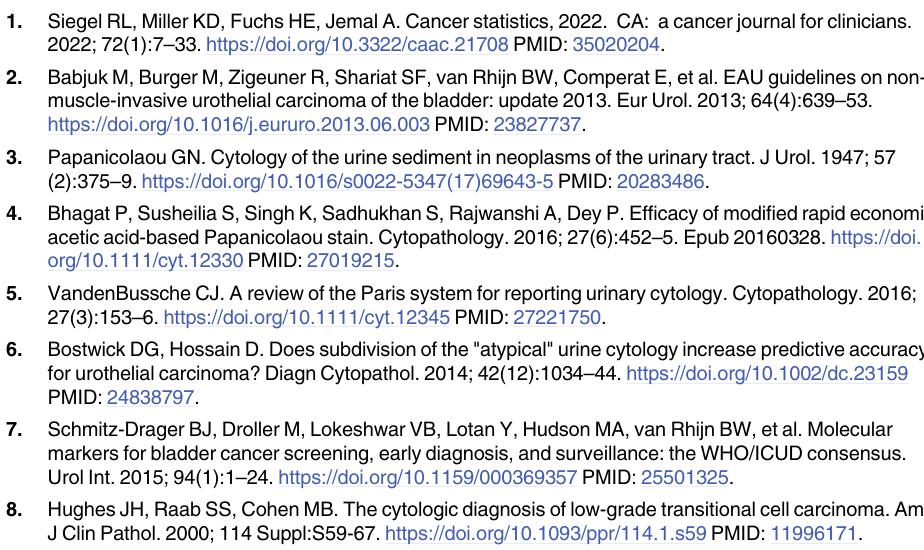
S2 Fig. Effects of CDCP1 knockdown in T24 cells on cellular invasion abilities and colony formation. T24 cells were transfected the CDCP1 specific shRNA plasmids for 24 hrs, (A) The invasion abilities of CDCP1-silenced cells and parental cells were measured. (B) Colony for- mation in soft agar was also performed to compare parental and CDCP1-silenced cells as described in “Materials and methods” section. Statistical analyses were analyzed by unpaired two-tailed Student’s t-test. The results were presented as mean ± SD (n = 3, � p < 0.05, �� p < 0.01, ��� p <